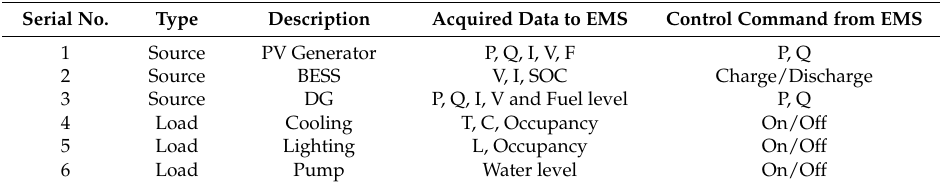
Figure 4. EMS controller data flow between controller, load and sources. Table 2. List of parameters acquired from loads and sources to EMS controller and corresponding output control from EMS.